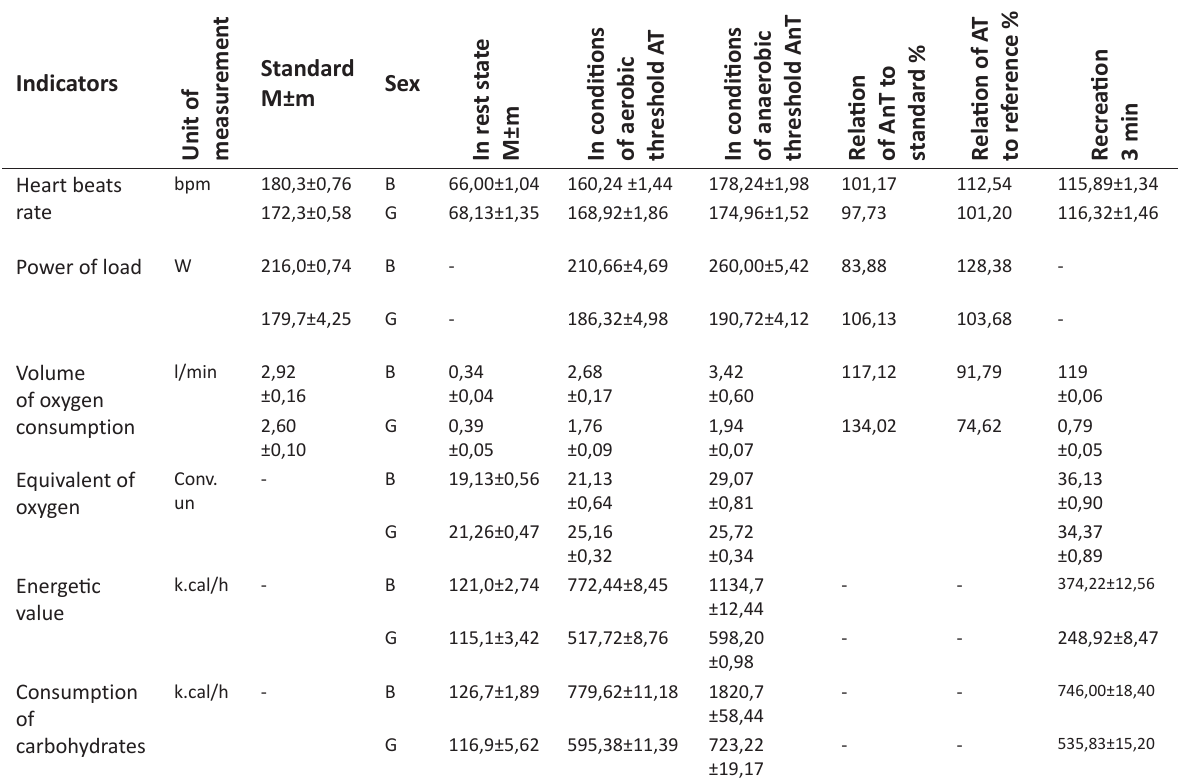
Table 2. Ergo-spiro-metry of sport orienteering (n=17 –boys; n=17 –girls)